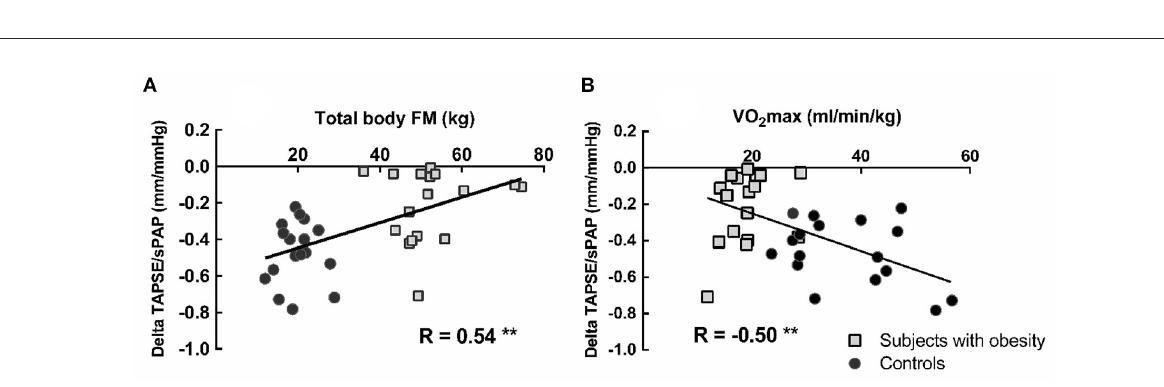
FIGURE4 Correlation between total body fat mass (FM) and peak exercise induced changes in TAPSE/sPAP (A) . Correlation between peak oxygen uptake (VO 2 peak) and the change of the TAPSE/sPAP ratio from rest to peak exercise (B) . Square markers represent patients with obesity, and circle markers represent the healthy control subjects. Lower VO 2 peak was associated with shallower changes in TAPSE/sPAP ratios. ** P <